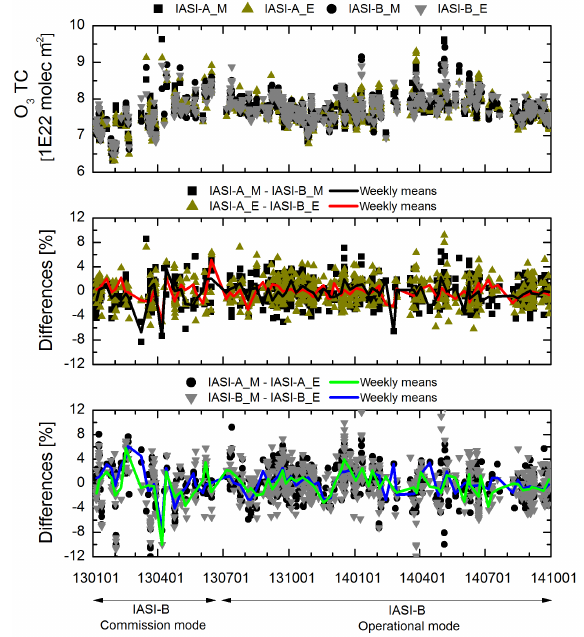
Figure 3. Time series of O 3 TC amounts (in 1 × 10 22 molecm − 2 ) from the IASI-A and IASI-B overpasses (morning, M, and evening, E) (upper panel) and of the differences between the cor- responding de-seasonalised variability (in %) for the morning and evening overpasses (middle and bottom panels). The solid lines rep- resent the difference time series averaged on a weekly basis. The ar- rows distinguish the IASI-B commission mode (from 19 December 2012 to 18 June 2013) and the IASI-B operational mode (from 19 June 2013